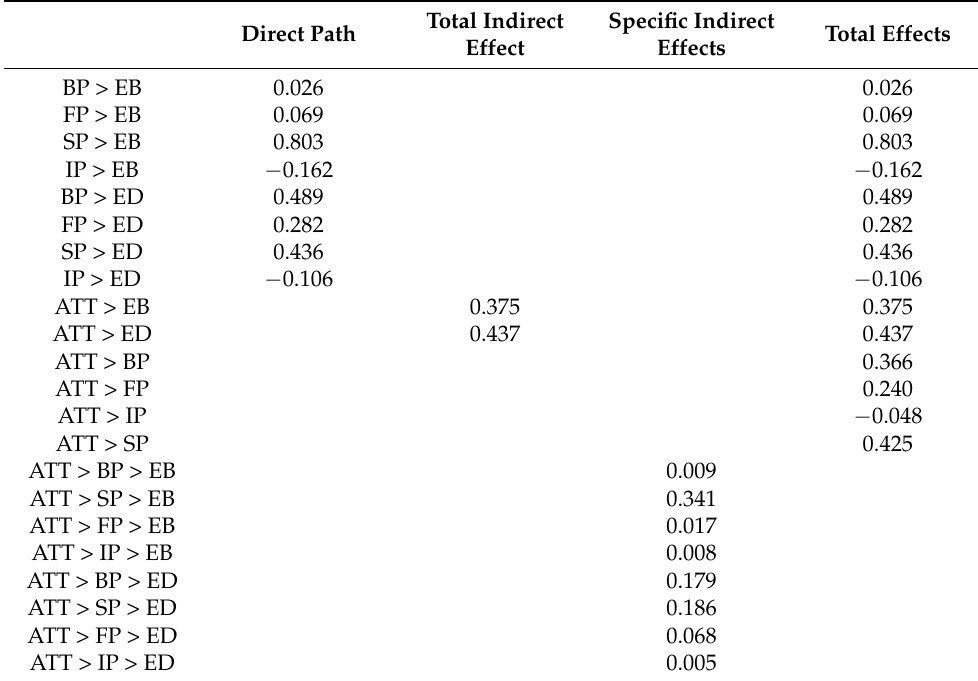
Table 7. Values of path coefficients in the